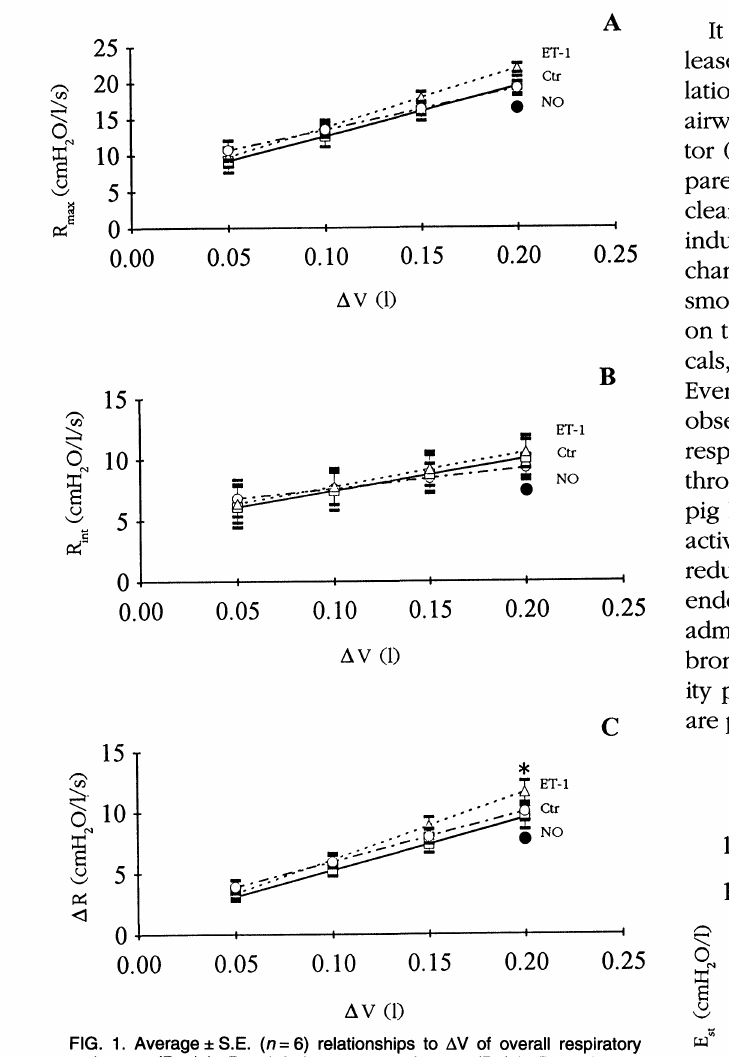
FIG. 1. Average +/- S.E. (n= 6) relationships to AV of overall respiratory resistance (R,ax) in Panel A; interrupter resistance (Rnt) in Panel B; and additional resistance (AR) in Panel C of the respiratory system. Ctr, control, (); ET-1 bolus administration, ); NO inhalation, ). The aster- isks (*) indicate statistically significant differences of Ctr vs. ET-1 (p < 0.05); (.) indicate statistically significant differences of ET-1 vs. NO (p < 0.05).